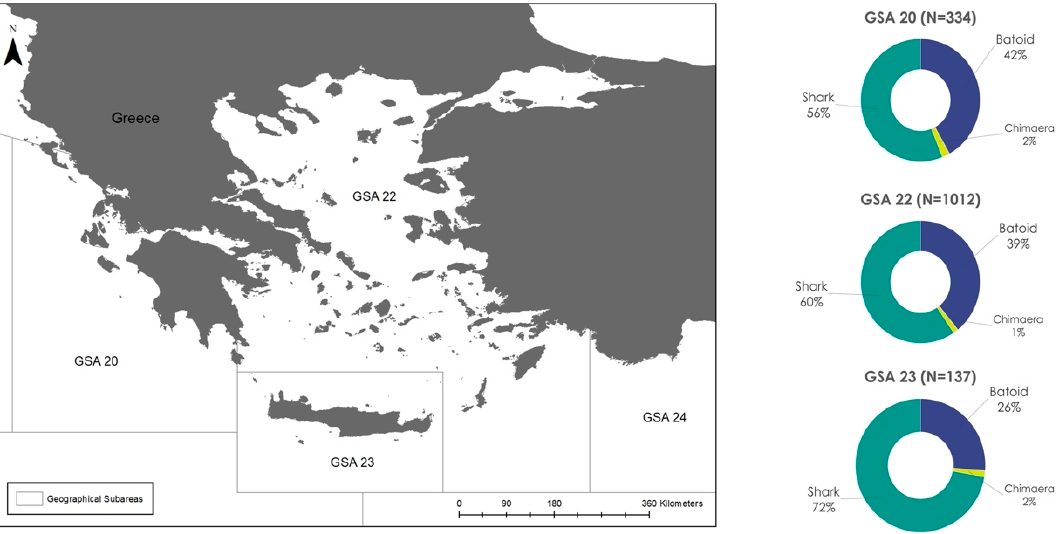
Figure 2. Map of the Geographic subareas (GSAs) in Greek waters and percentage of entries found that referred to sharks, batoids or chimaeras in the GSAs.